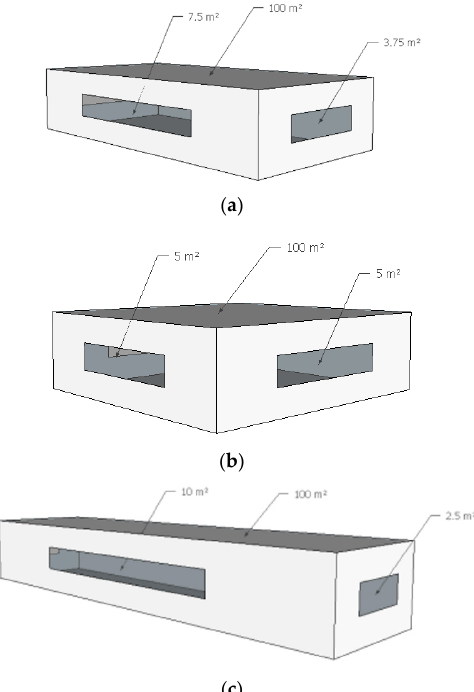
Figure 2. Visual representation of a 100-x-15-0 building with AR value equal to: ( a ) 0.5 or 2; ( b ) 1; ( c ) 0.25 or 4. Table 6. Compactness of buildings with different SA values and AR equal to 2.